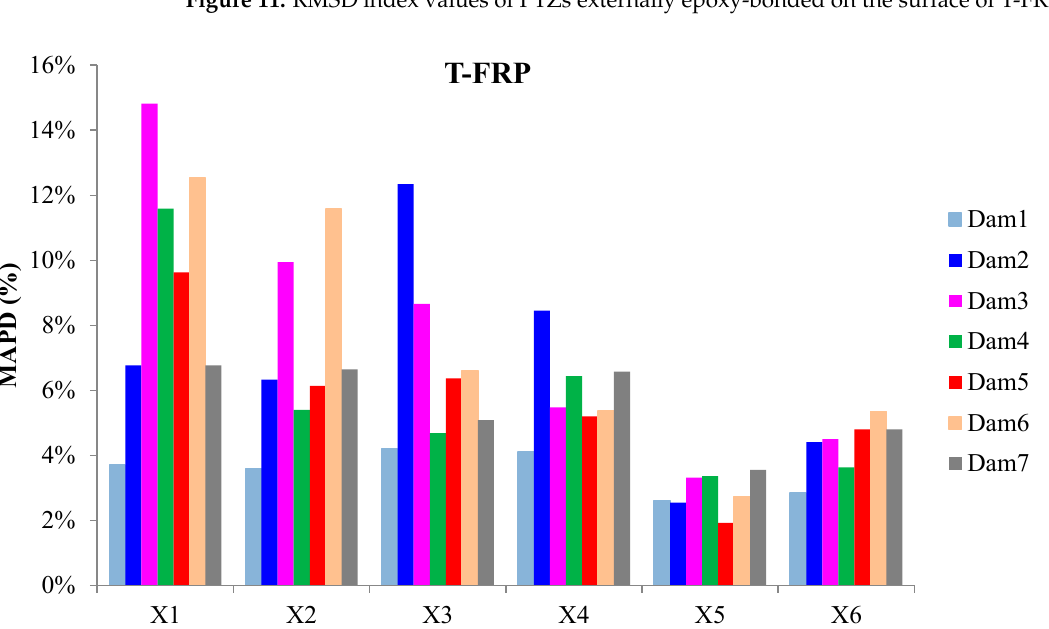
Figure 12. MAPD index values of PTZs externally epoxy-bonded on the surface of T-FRP. In addition, the dynamic metrics of moving RMSD (mRMSD) and moving MAPD (mMAPD) were employed at a frame of overlapped moving blocks of 50 consecutive data points to enhance the damage location process. Furthermore, the moving indices were implemented for a frequency range of 100–150 kHz within which the resonant of the external-bonded PZTs was included. Figures 13 and 14 depict the moving RMSD and the moving MAPD charts at the resonant frequency for each externally bonded PZT patches for the damage cases 2, 3, and 4, where the first flexural, the first right shear, and the first left shear cracks were formed, respectively. Figure 13. mRMSD at the resonant frequency of PTZs externally bonded on the surface of T-FRP.